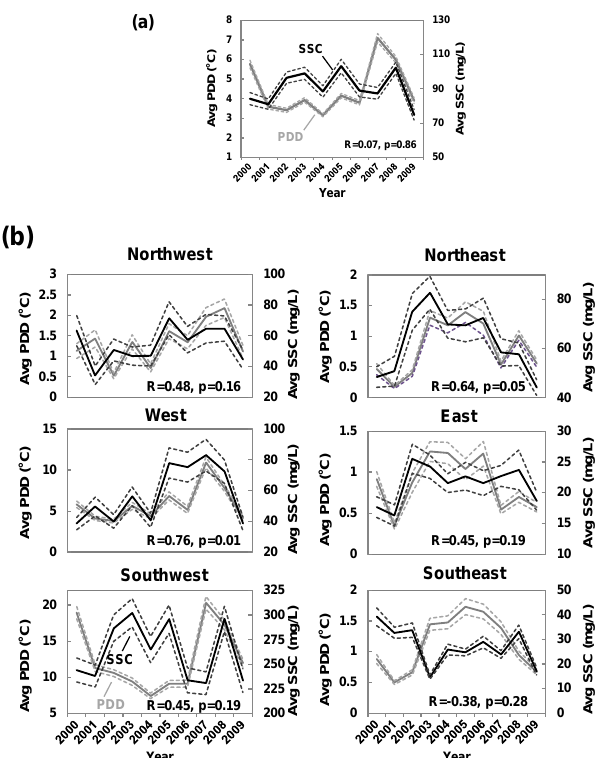
Fig. 6. Interannual variations of ice sheet PDD and plume SSC for the (a) entire ice sheet and for (b) each of the six regions from 2000–2009, with 95% confidence intervals. The West and North- east regions track each other rather well, while the Southwest and Southeast regions are fairly